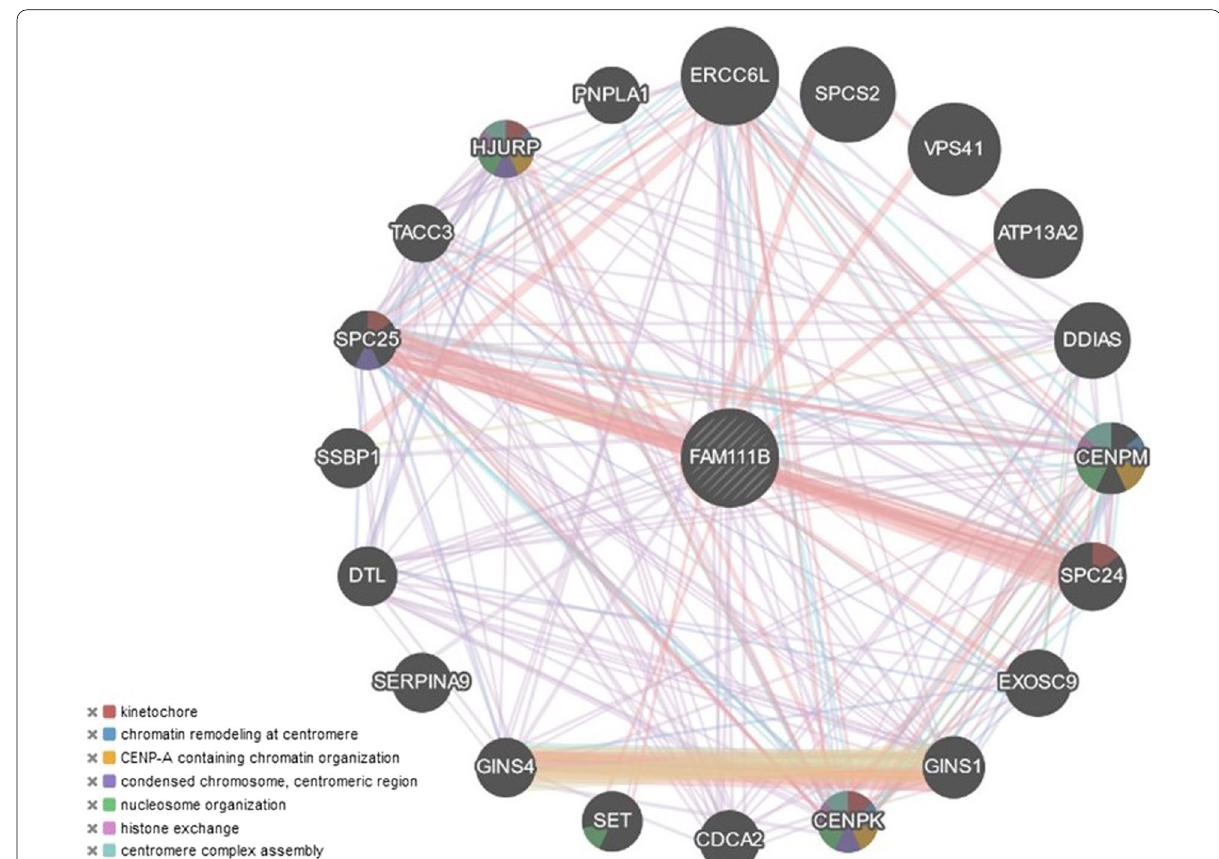
Fig. 2 Gene–gene network analyses performed by genemania tool highlighting the interactions of FAM111B protein with proteins sharing functional